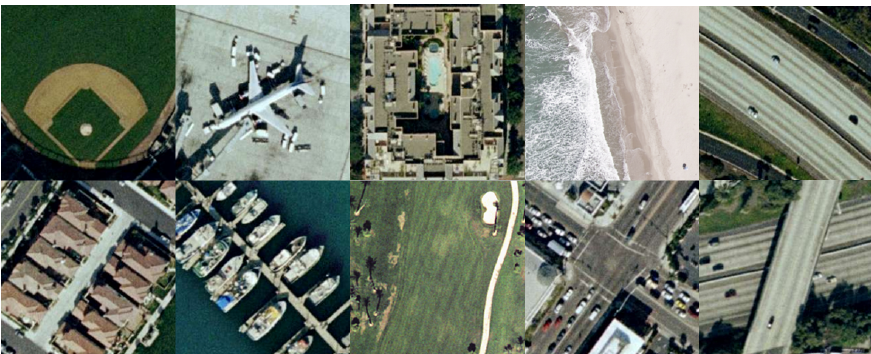
Figure 2. Samples of UC Merced Land Use dataset.